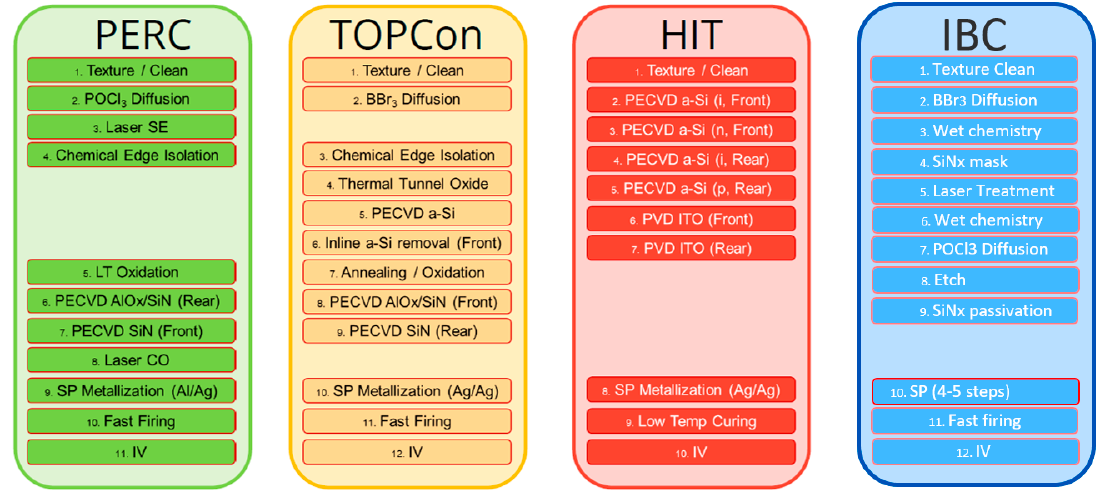
Figure 4. Process flows for PERC, TOPCon, HJT and IBC.